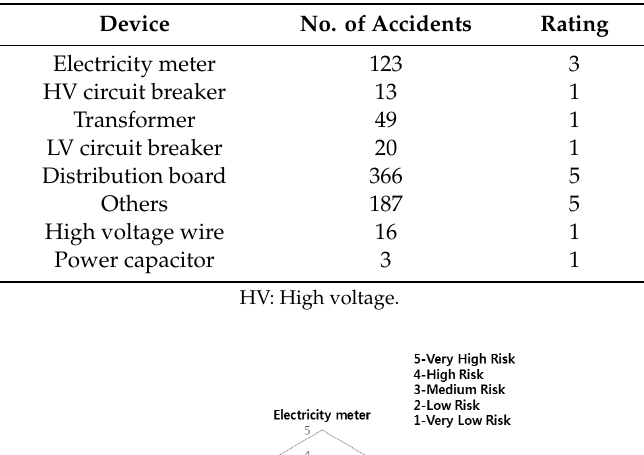
Figure 19. The risk rating for high voltage equipment by device. Table 10. The number of accidents and risk rating for ignition equipment.